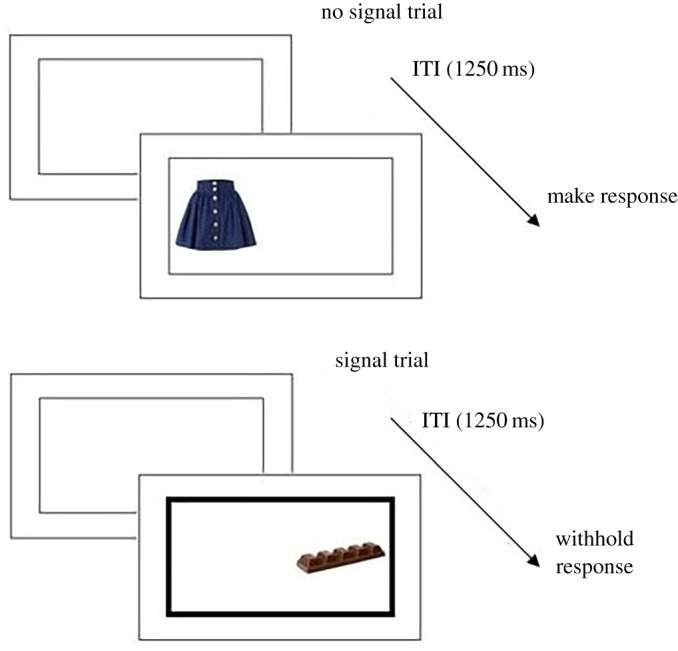
Visual schematic of the Go/No-Go training task. ITI = inter-trial interval.